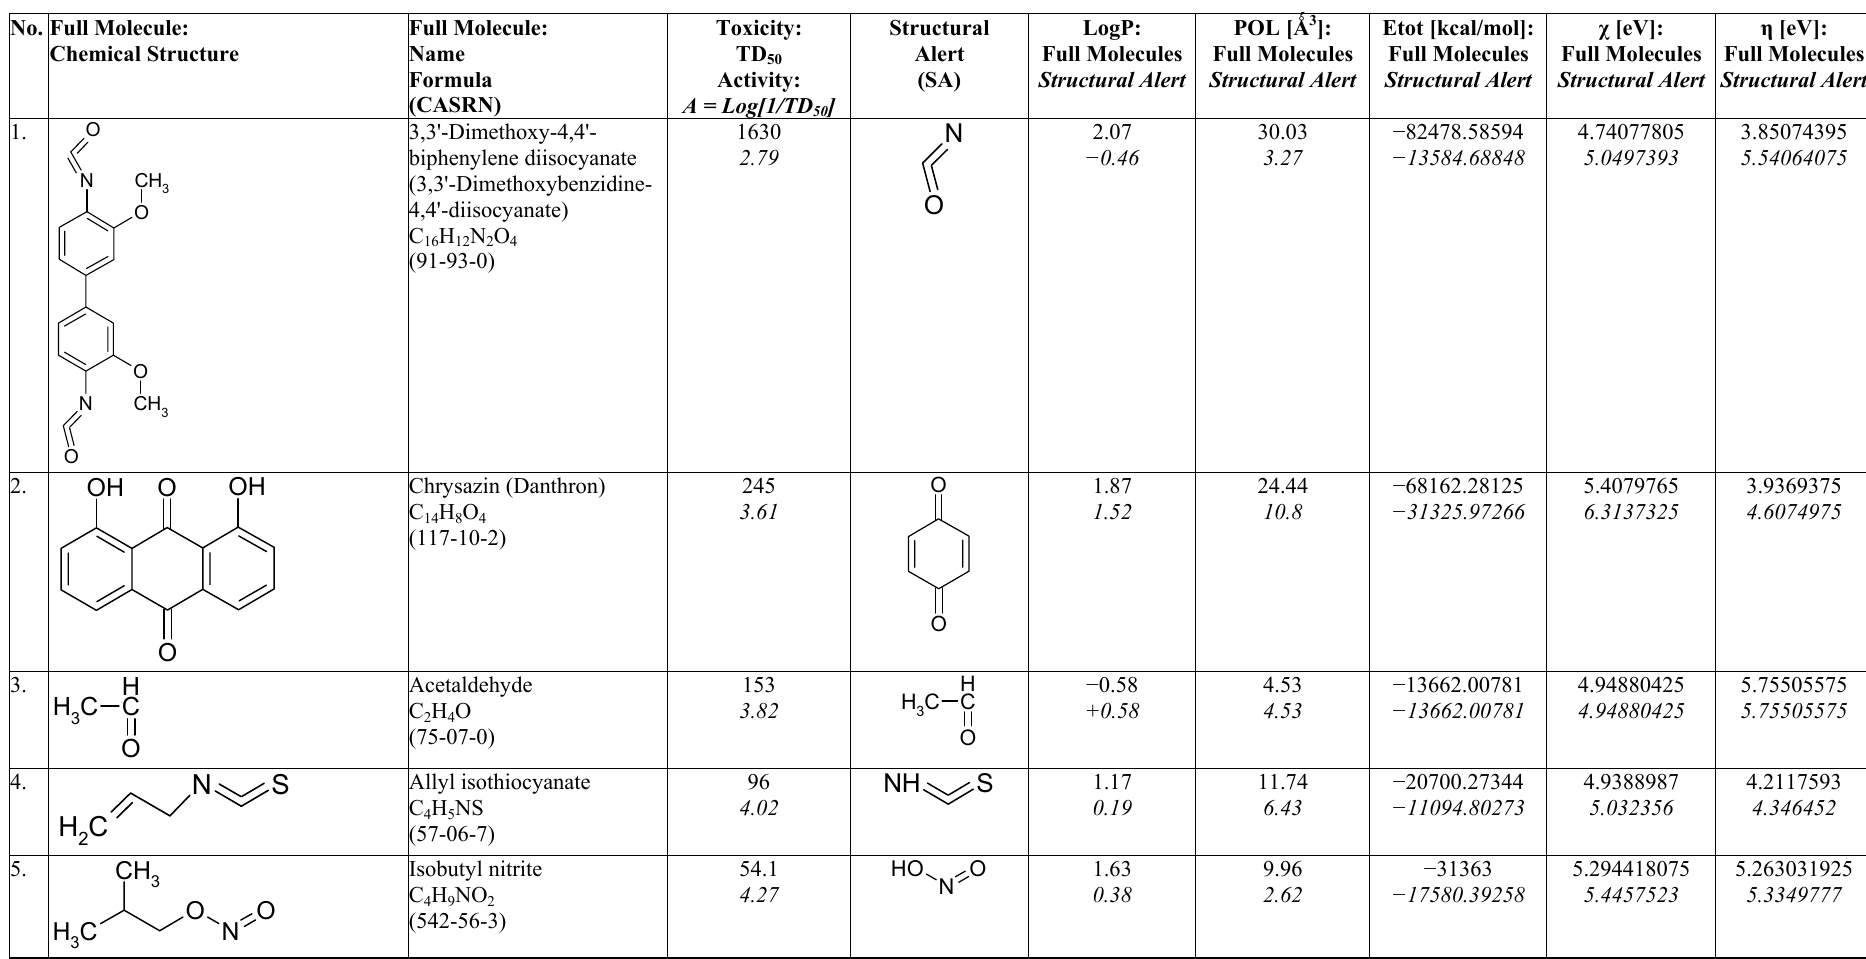
toxicities (in mg/kg body wt/day) [16] and 50 + ε )) [eV], and chemical hardness LUMO HOMO